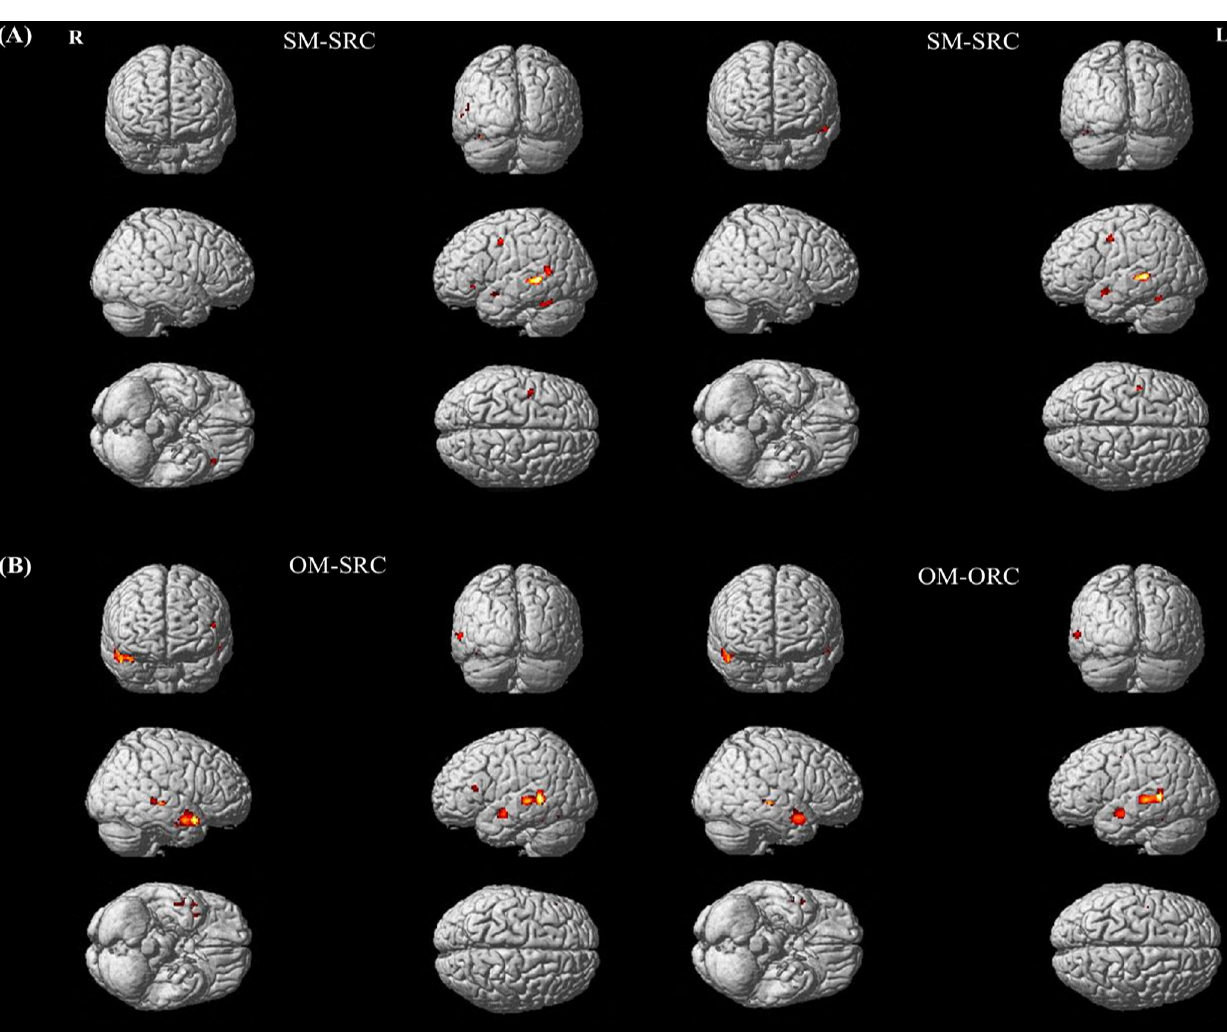
Fig 3. Volume rendering of SM-SRC, SM-ORC, OM-SRC and OM-ORC sentences. The similar bilateral activation patterns are identified in response to the processing of the SRC and the ORC, regardless of the modifying position. The results show that (A) for the SM-RC sentences, only a left-lateralized frontotemporal neural network is involved; whereas (B) for the OM-RC sentences, besides the typical left-hemispheric brain areas, the right superior temporal gyrus (RSTG) is also recruited in sentence processing.